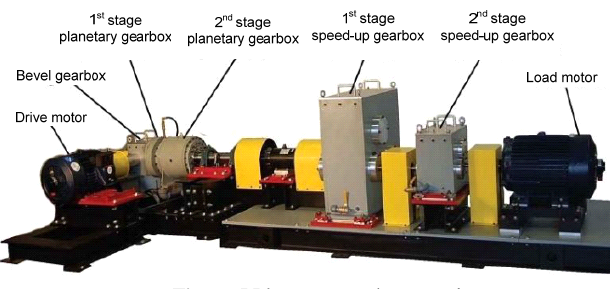
Figure 24. The planetary gearbox test